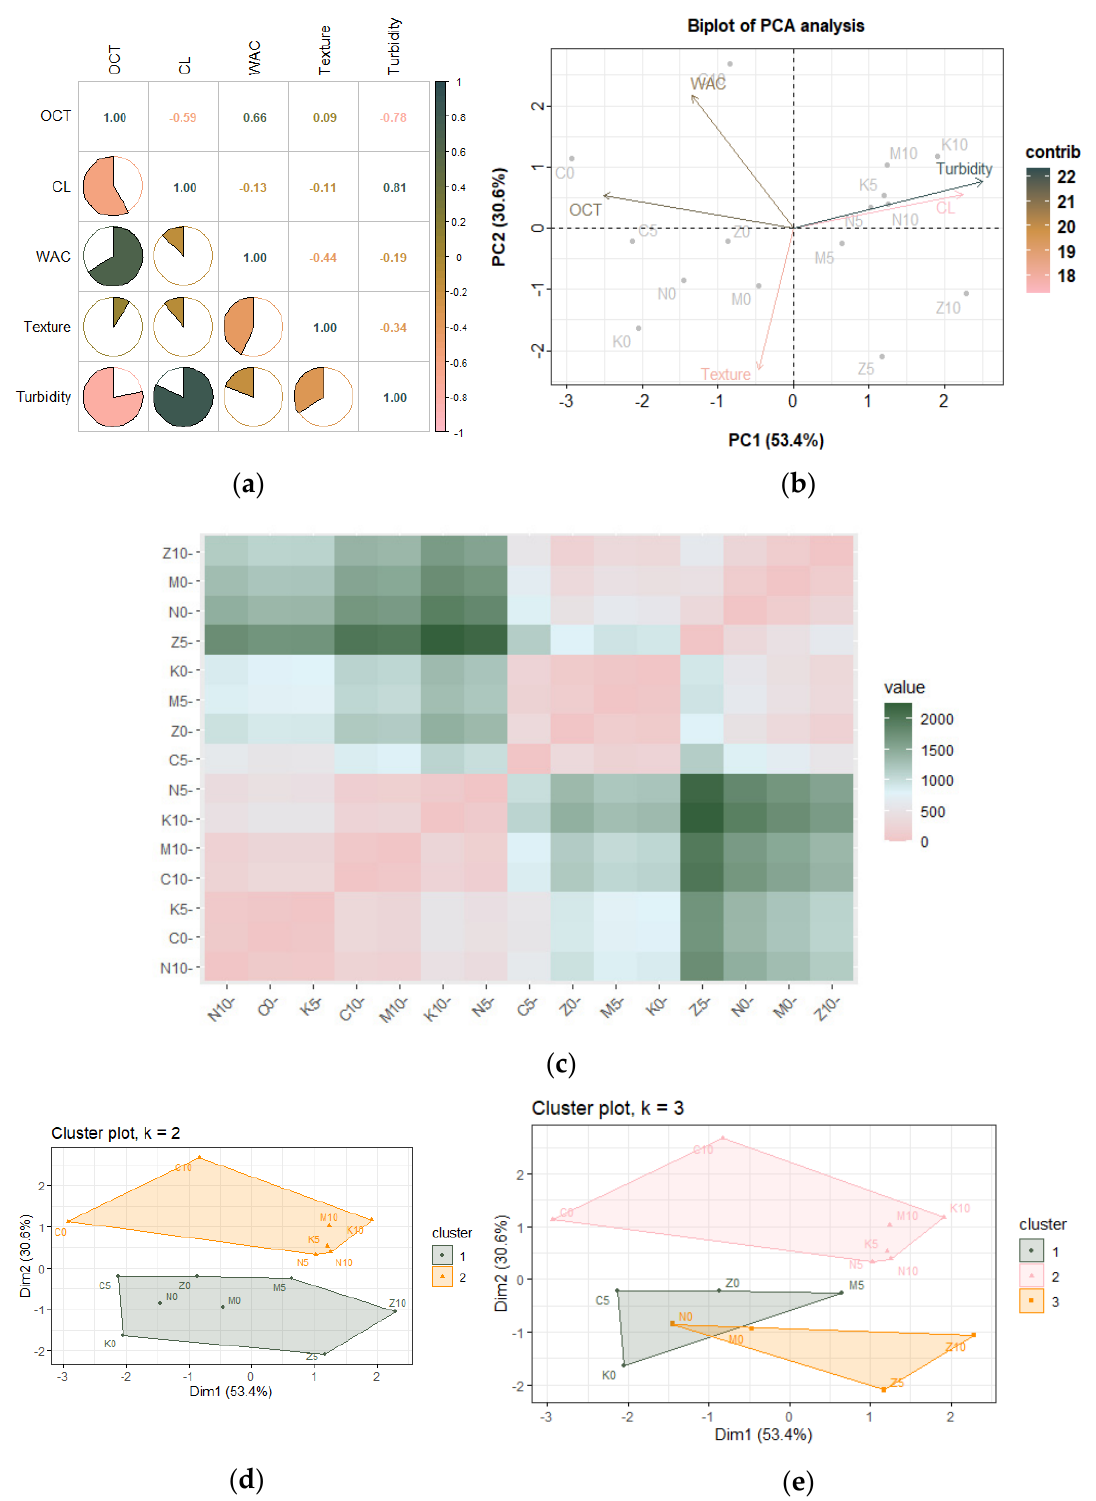
Figure 3. Figures showing the ( a ) Pearson correlation matrix for noodle quality indices; ( b ) PCA biplot showing the loadings of variables and individuals of each sample over the first two principal components; ( c ) pairwise distance matrices illustrating dissimilarities. K-means cluster plots with ( d ) two centers, and ( e ) three centers, at 95% confidence level.